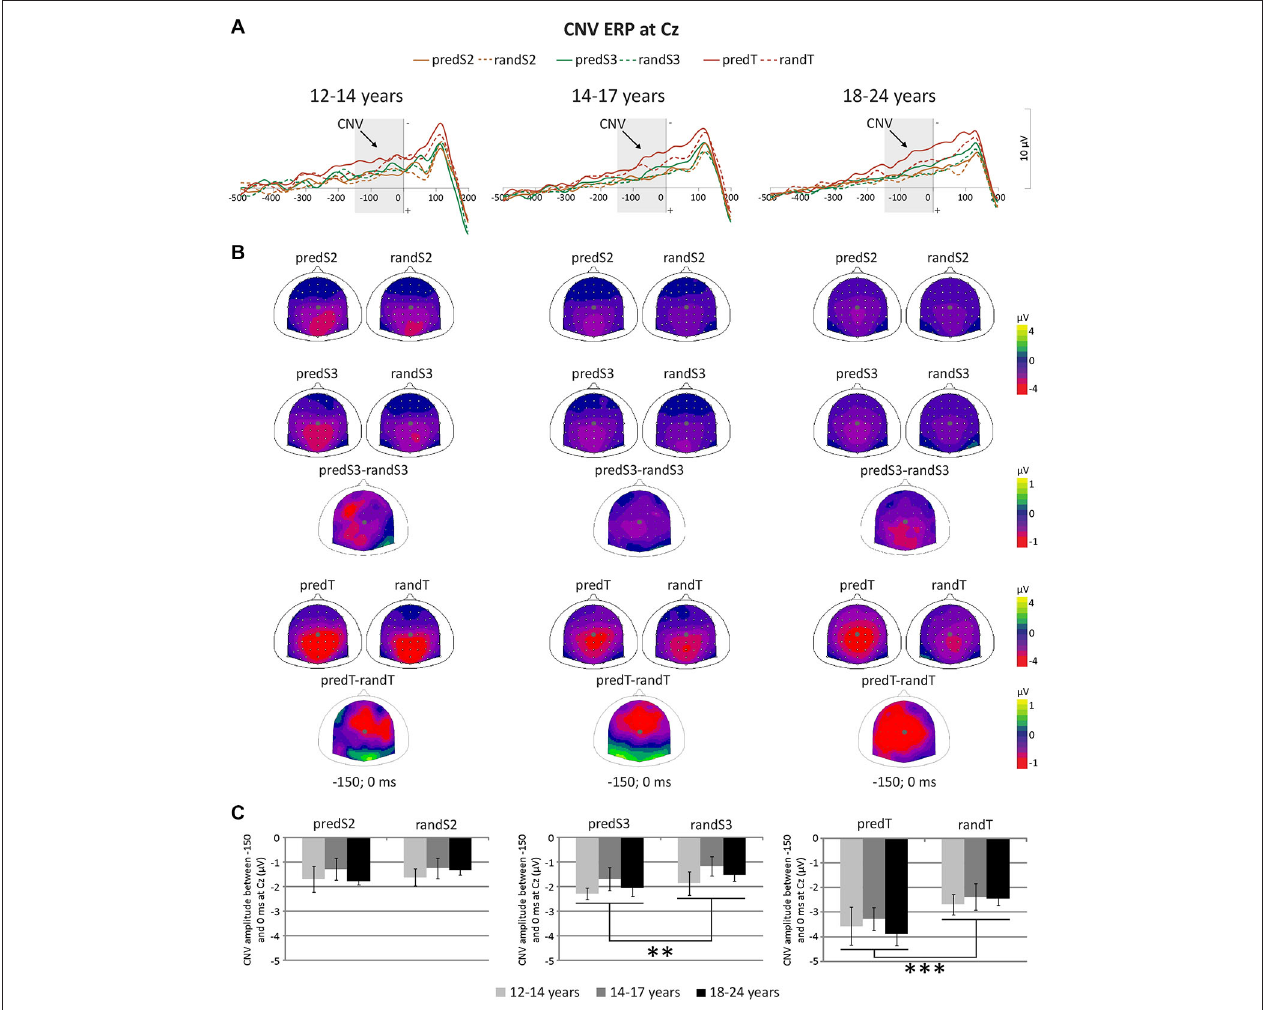
FIGURE 5 | Predictive processing: CNV ERP. (A) Grand-average non-baseline-corrected ERP waveforms band-pass filtered between 0.5 and 30 Hz, at the Cz electrode. (B) Scalp topographies (top views) of the mean CNV ERP for each pair of predictive stimulus and its non-predictive analog, and for the difference between predS3 and randS3 and between predTs and randTs in the − 150–0 ms time-window. The gray dots indicate the position of Cz. (C) CNV amplitude between − 150 and 0 ms in µ V at Cz for predS2 and randS2, for predS3 and randS3, and for predicted and random targets. Error bars: standard errors of mean. Significant differences are indicated by asterisks: ∗∗ p ≤ 0.01, ∗∗∗ p ≤